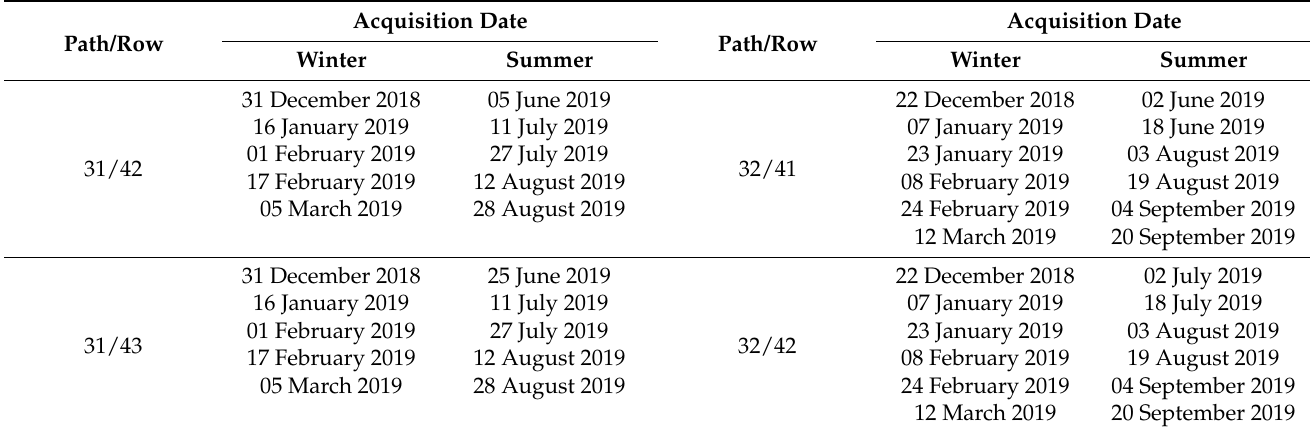
Table 1. Path/Row and acquisition dates of Landsat-8 images.